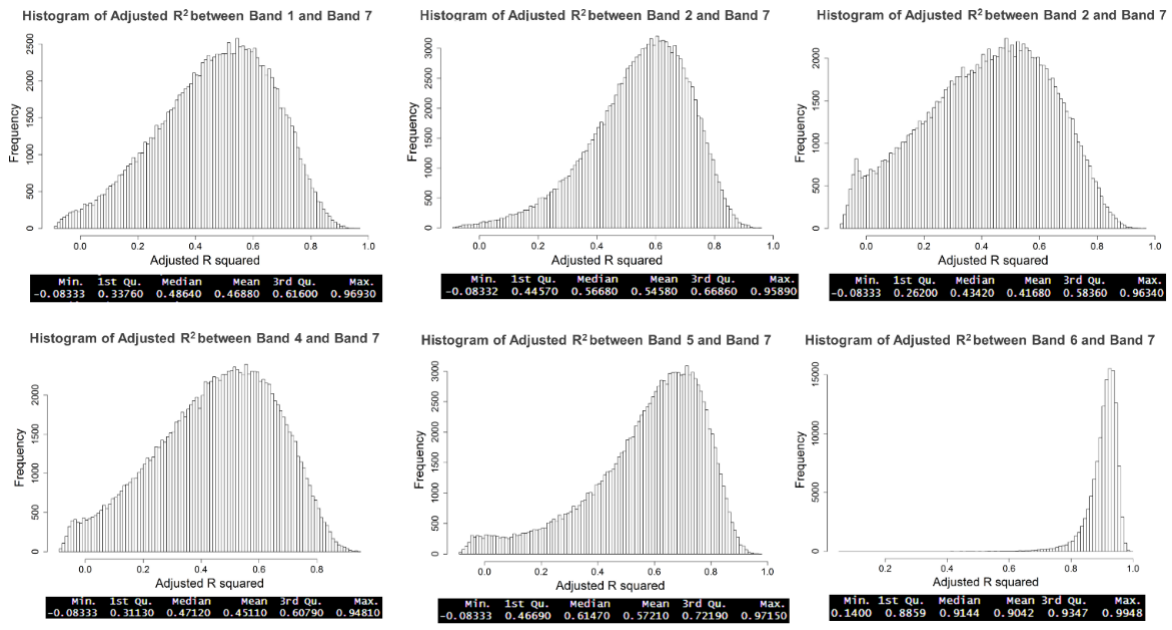
Figure 9. Histogram of adjusted R 2 for each location in entire study area between bands 1–6 and band 7. The highest mean of adjusted R 2 appears in band 6, the lowest in band 1 and band